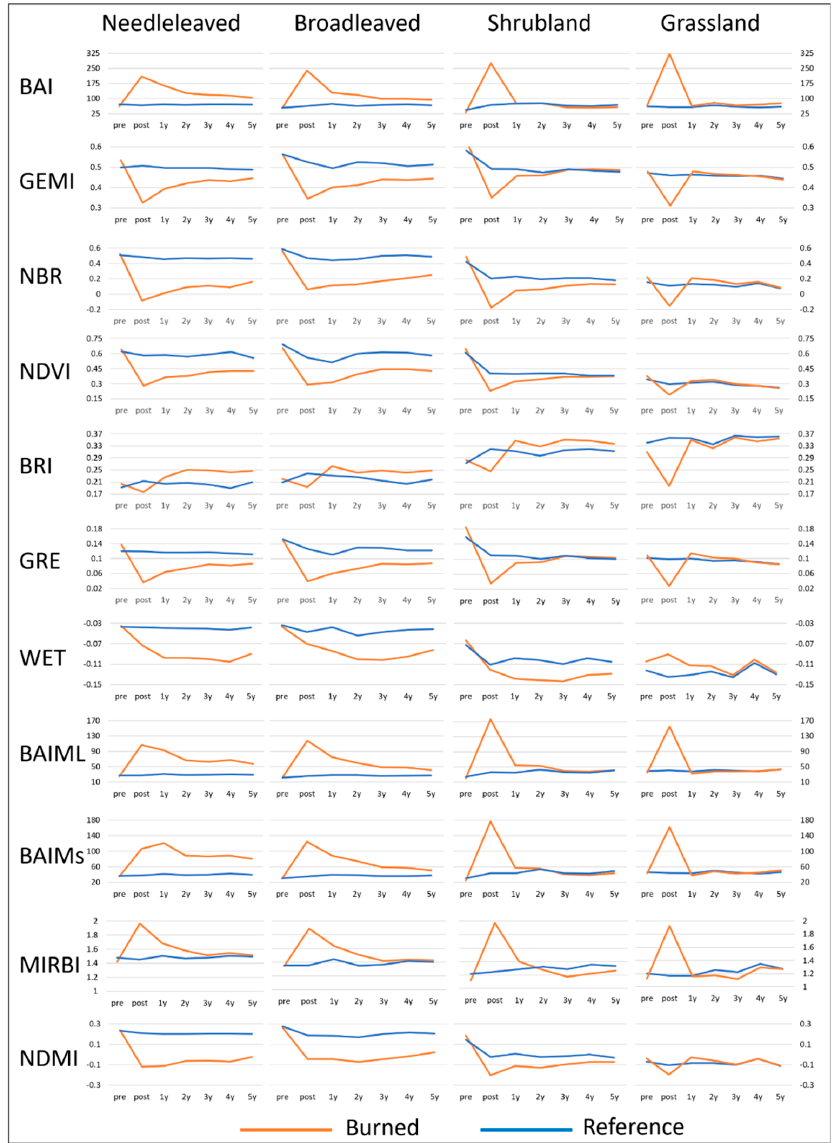
Figure 5. Temporal trajectories for 11 spectral indices in four major vegetation types in northwest